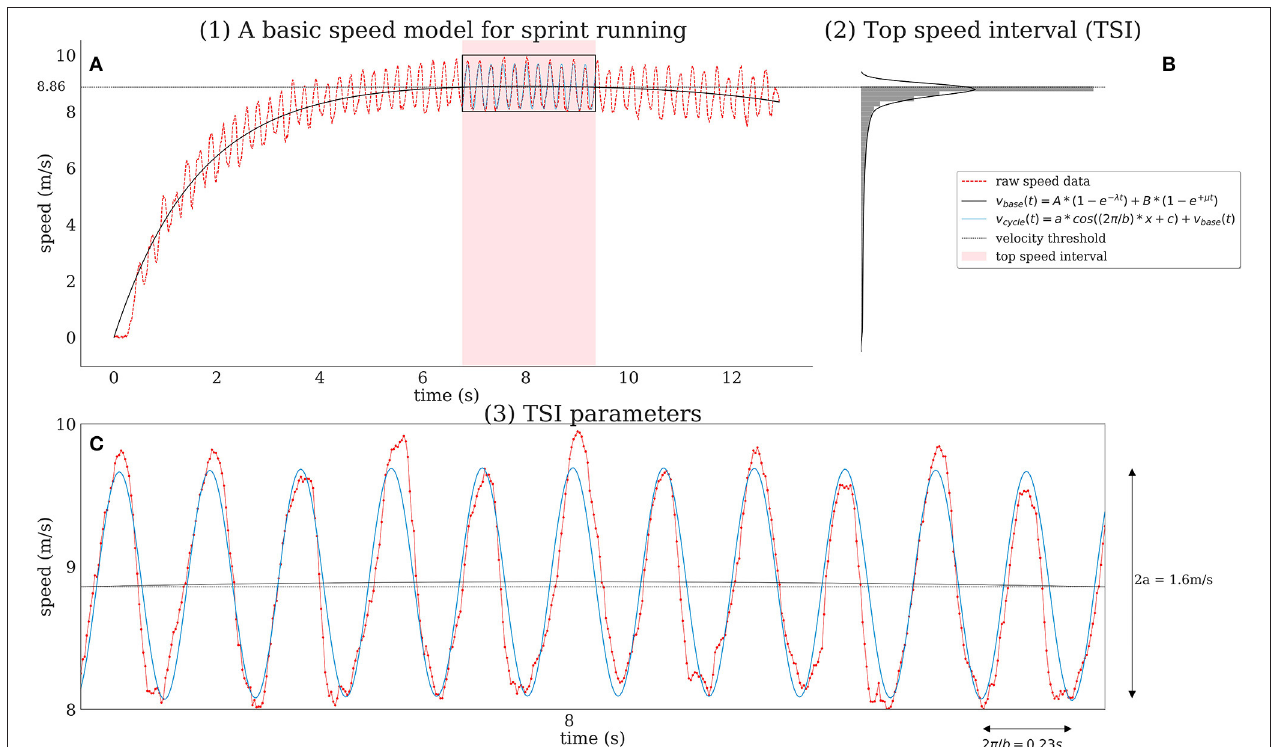
FIGURE 2 | An overview of the three-step modeling process is shown for a sample run of a male sprinter. We start by fitting the basic speed model proposed by ( Fuchs and Lames, 1990) (A) —application to raw data (red dotted line) yields a smooth speed curve (solid black line) and provides estimates for maximum speed, maximum acceleration, and speed endurance. We then obtain a run-specific Top Speed Interval [TSI, light red shaded area in (A) ] which corresponds to the time period when running speed is within the top 20% percentile of an athlete’s running speed for the given run (B) . Its calculation is based on the modeled speed (solid black line) rather than the raw speed data (dotted red line) and the corresponding velocity threshold (dotted black line, here: 8.86 m/s). Within the TSI we obtain intra-cyclic parameters (amplitude, step time, and step length) by fitting a cosine model (blue solid line) to raw speed data (C)